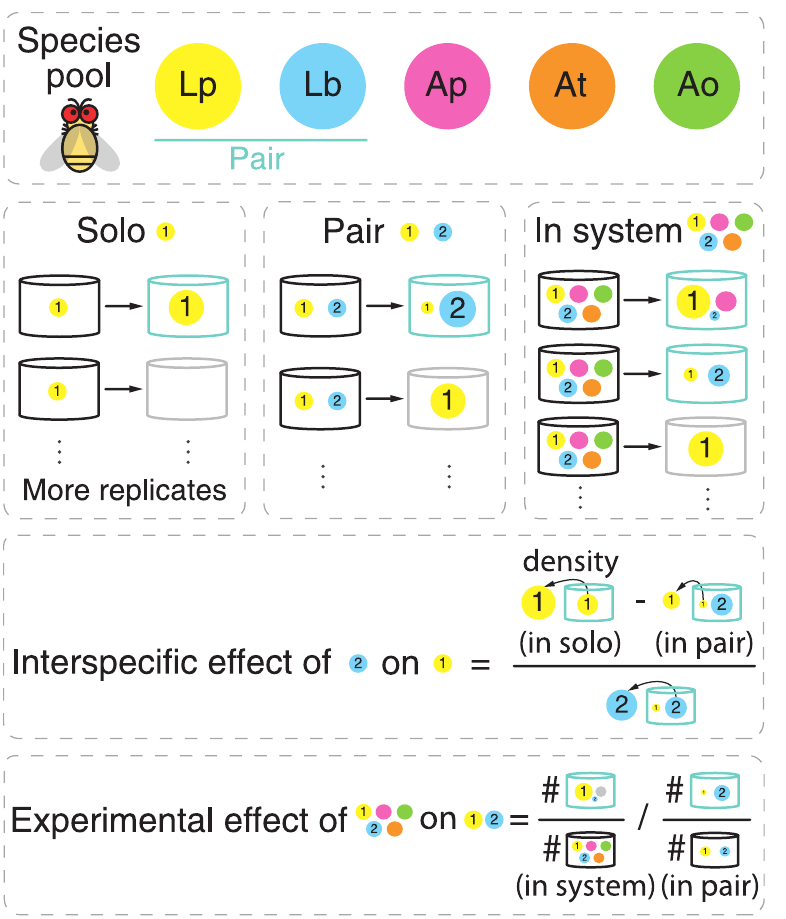
Fig 3. Illustration of experimental data, inference of pairwise interactions, and calculation of experimental effects. We use publicly available data of an in vivo gut microbial system. The data set was generated in Ref. [15] and it comprises ten-day experimental trials of five interacting microbes commonly found in the fruit fly Drosophila melanogaster gut microbiota: Lactobacillus plantarum (Lp), Lactobacillus brevis (Lb), Acetobacter pasteurianus (Ap), Acetobacter tropicalis (At), and Acetobacter orientalis (Ao). From the available experimental data, we used the results from monoculture experiments for each species, co-cultures experiments for each pair, and poly-culture experiments for the quintet. Each experiment was replicated across different hosts and each species’ density was measured at the end of the observation period, providing a single record of persistence for each species in monocultures, co-cultures, and poly-cultures per replication. The experimentally-inferred pairwise matrix A was inferred using the data of monoculture experiments for each species (e.g., species 1) and co-cultures experiments for pairs (e.g., pair {1, 2}) by evaluating the modified abundance of species 1 with and without species 2 at the end of the observation periods (see S2 Appendix). We define the experimental effects of the third-party species on pair {1, 2} as the difference in the experimental frequencies of occurrence of the pair across all replicates with third-party species and the experimental frequencies of occurrence of the pair in